Question: Compose a caption that would accompany this figure in a paper.
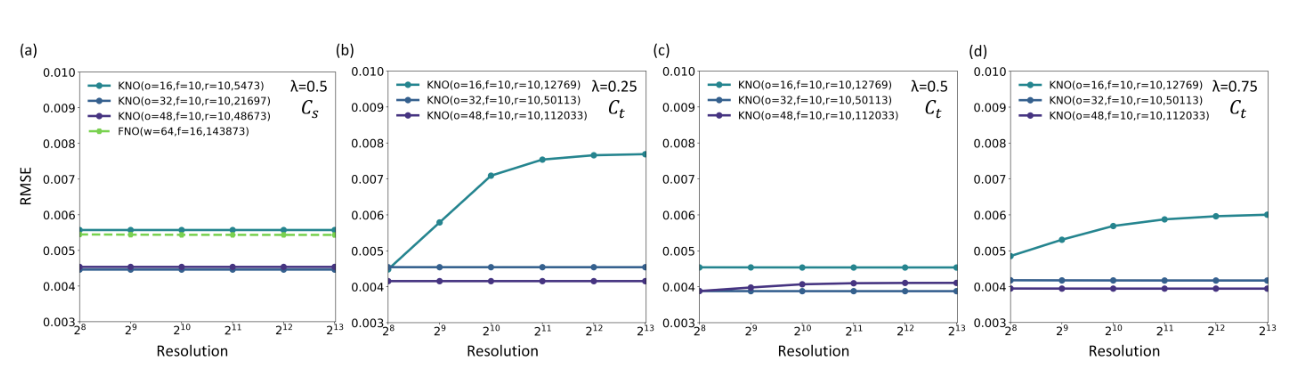
Answer: Results of the zero-shot experiment (discretization granularity) on the 1-dimensional Bateman–Burgers equation. (a-d) respectively present the results under different conditions of high-frequency complement designs and λ in the KNO. Here the high-frequency complement can be either realized by a single convolutional layer, Cs, or by a simple tripartite convolutional network, Ct. Parameter λ controls the contributions of low- and high-frequency information.